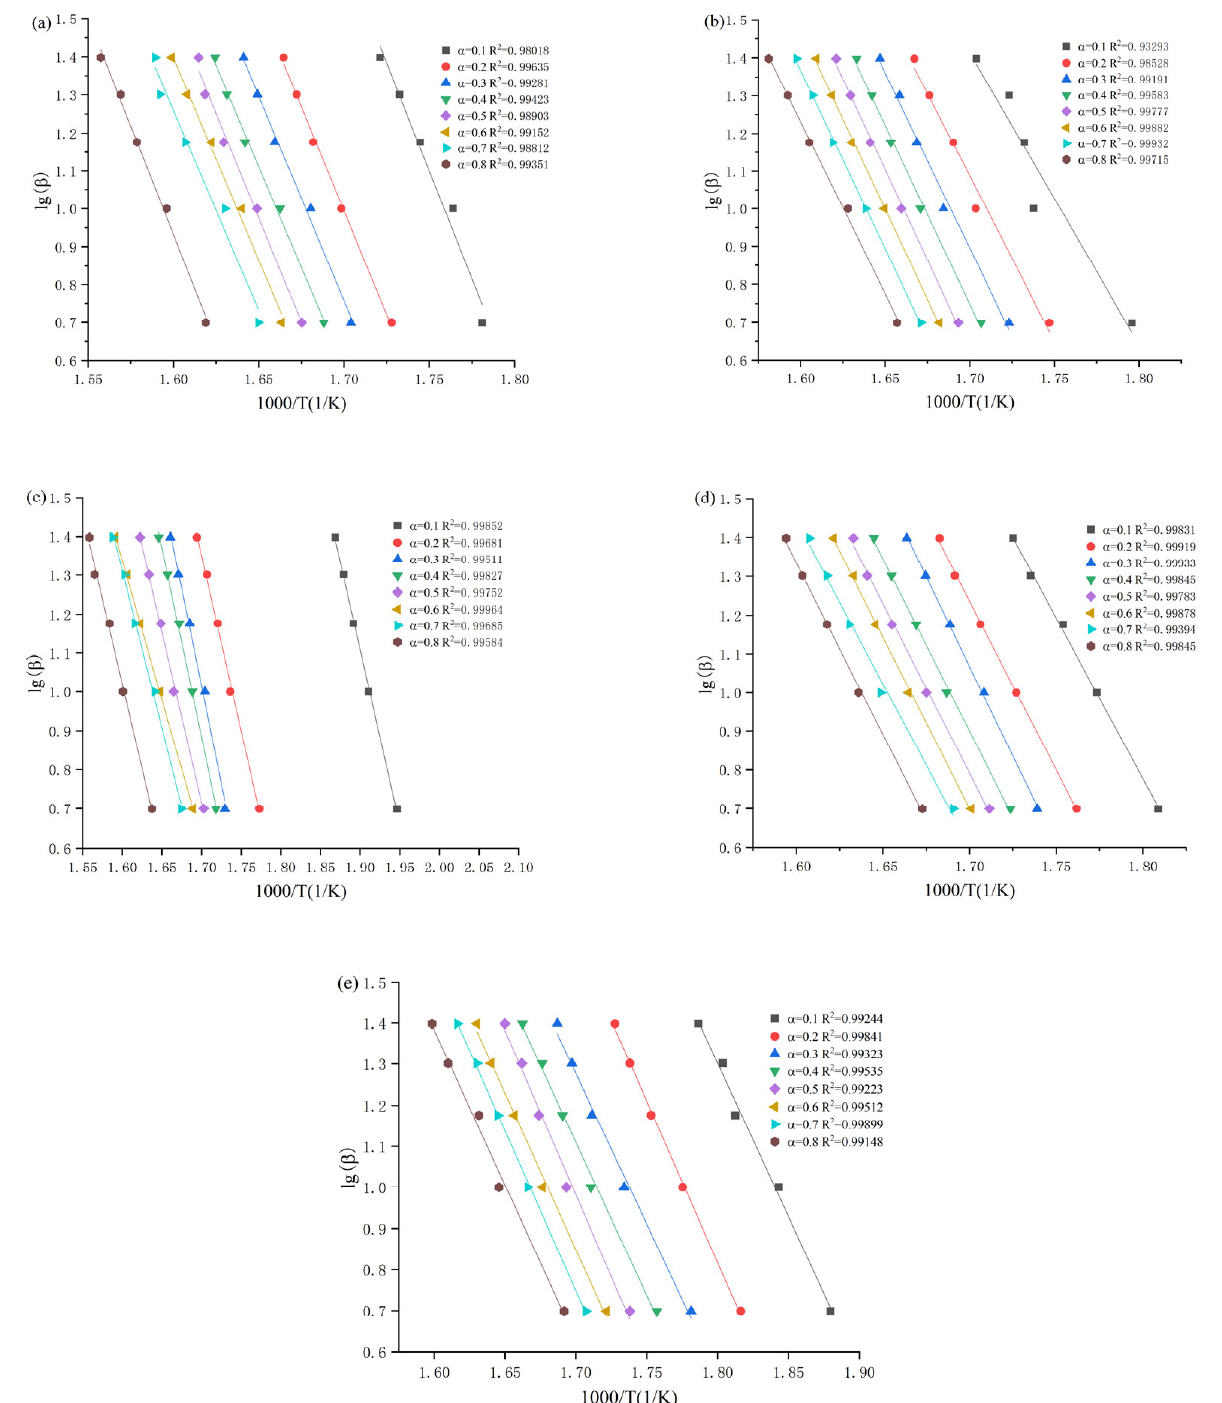
Figure 7. Fitting results of the Flynn–Wall–Ozawa method for [Emmim][NO 3 ] ( a ), [Bmmim][NO 3 ] ( b ), [Hmmim][NO 3 ] ( c ), [Ommim][NO 3 ] ( d ) and [Dmmim][NO 3 ] ( e ).